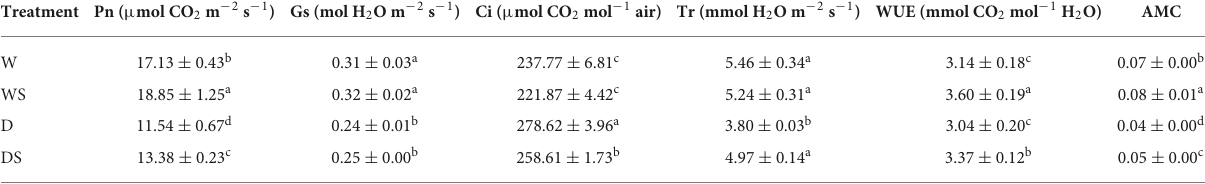
TABLE 1 Effects of silicon on the leaf photosynthetic parameters of rice under flooding and dry